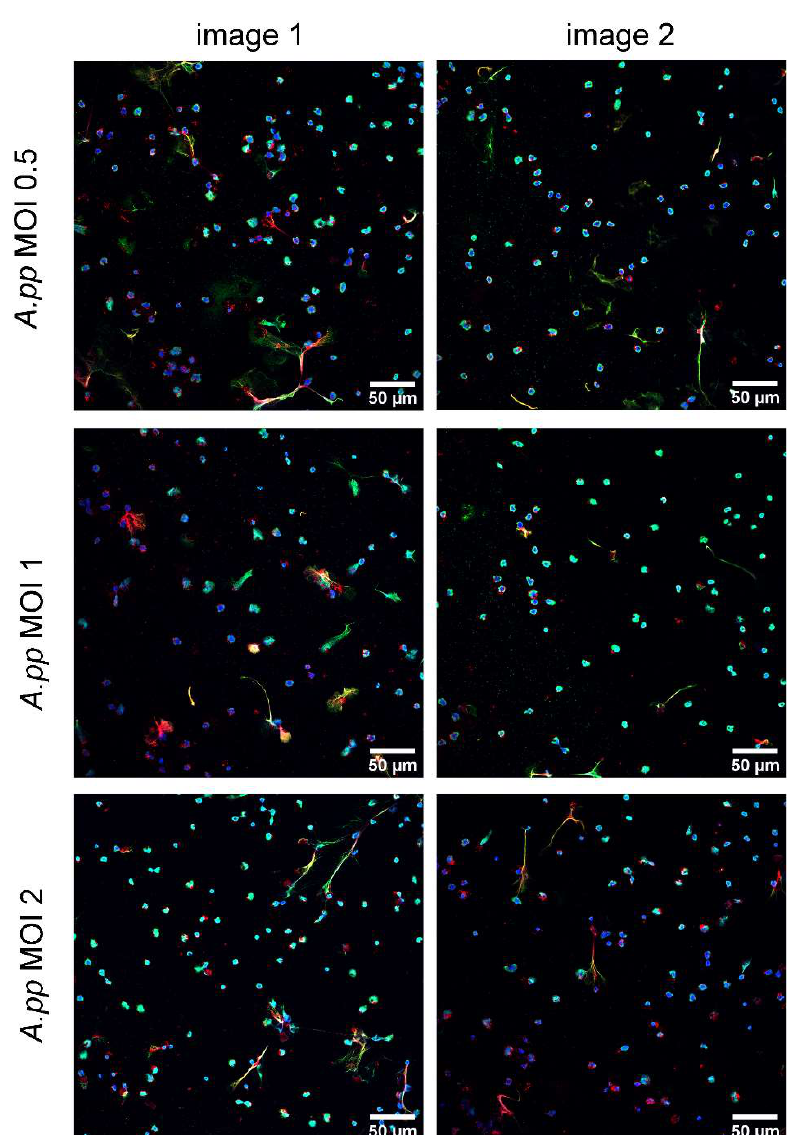
Figure A1. Representative immunofluorescence images (overlay) of neutrophils treated for 3 h with different MOIs of A.pp (MOI = 0.5, 1, and 2). For each treatment two out of six images are presented. Comparable NET release was observed in all samples. Settings of the microscope were adjusted based on an isotype control (blue = DNA, DNA/histone-1-complexes = green, myeloperoxidase = MPO).